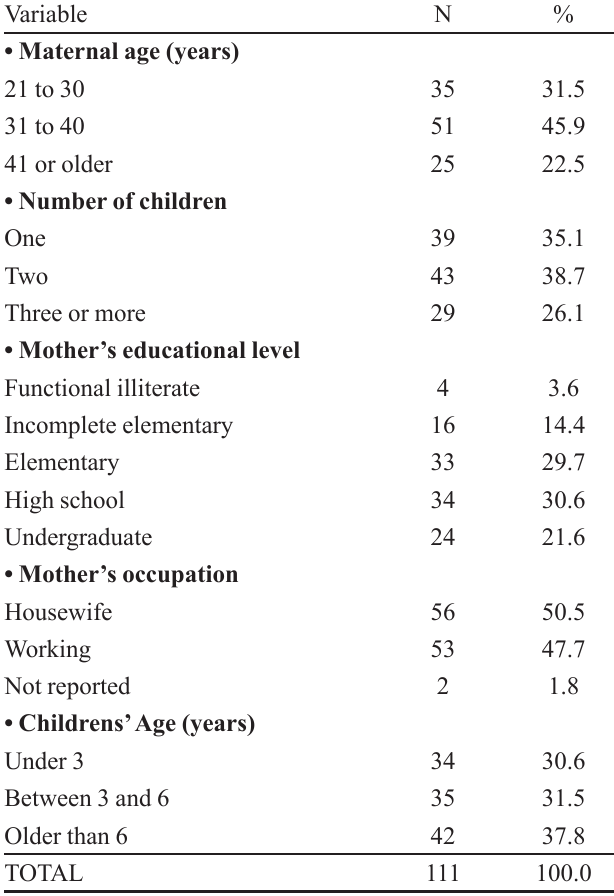
TABLE II - Sample distribution by variables related to “Maternal Knowledge on Use of Pediatric